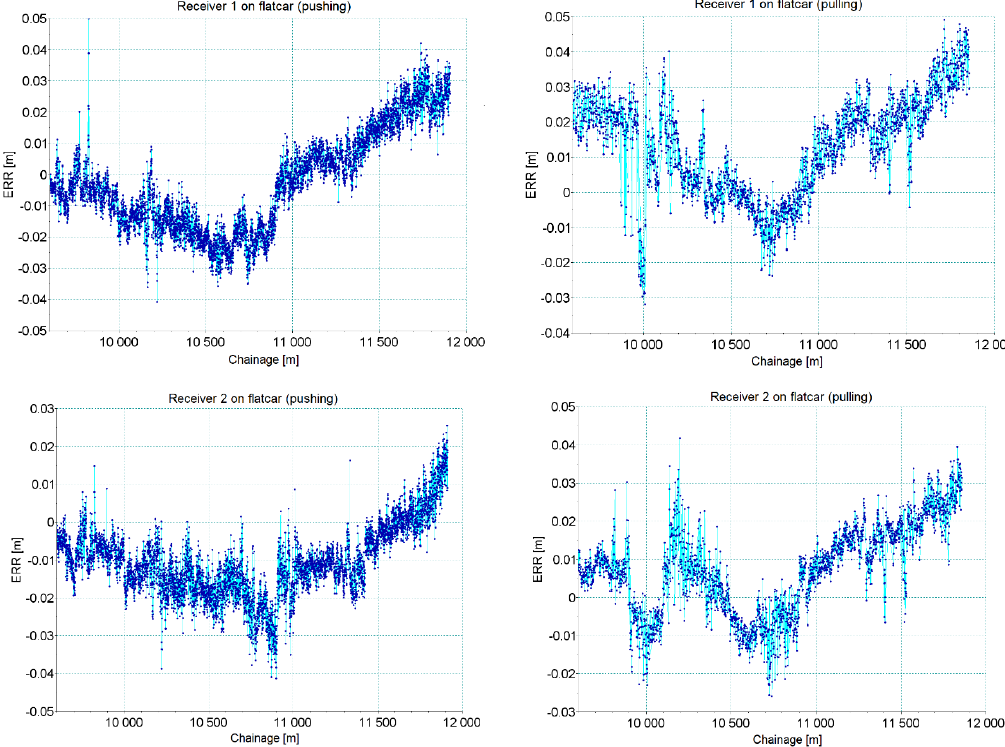
Figure 15. Distribution of errors for different GNSS signals in relation to the tacheometry measurements.